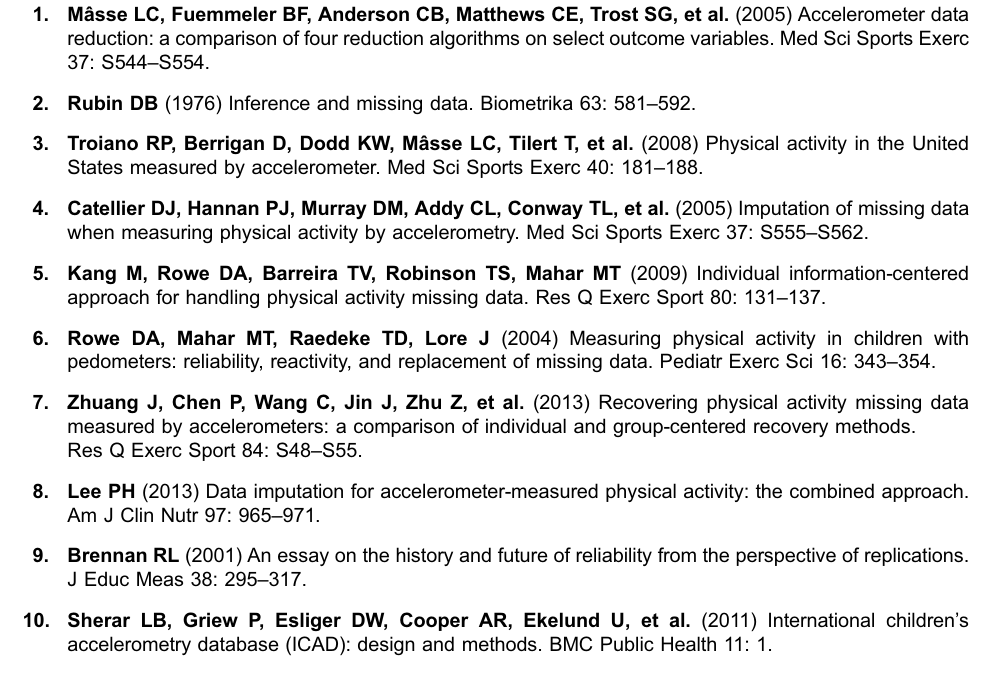
Table S1. Data structure and G theory calculations. Table S2. Variance component equations and